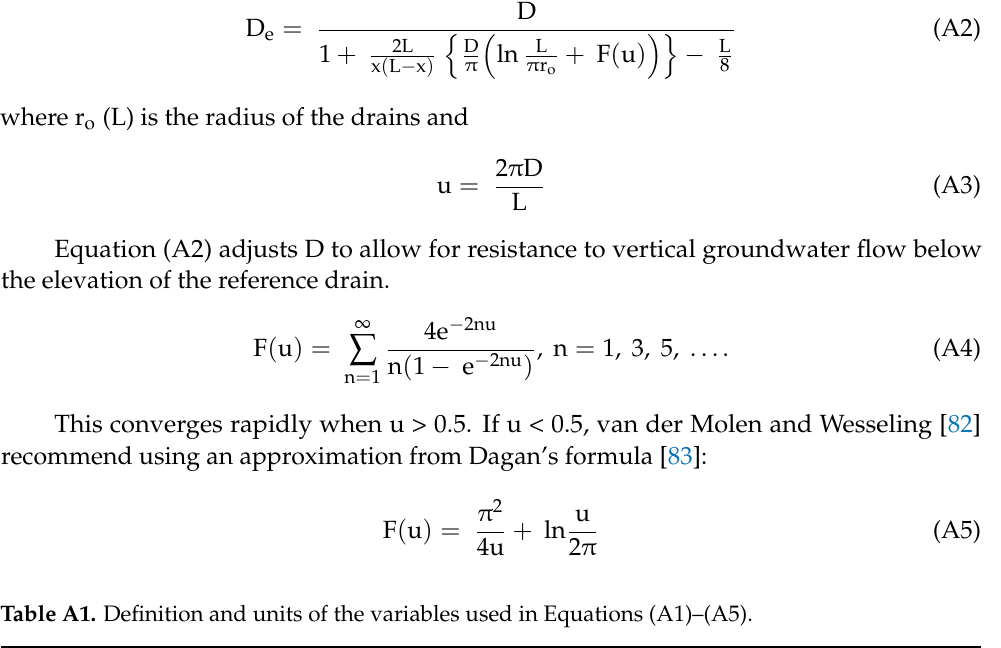
Table A1. Definition and units of the variables used in Equations (A1)–(A5). Variable Units Definition R L/T recharge K LT hydraulic conductivity equivalent depth accounting for vertical resistance to flow below L drain level z t L topographic elevation elevation difference between two drains horizontal distance between reference drain and water-table outcrop horizontal distance between two